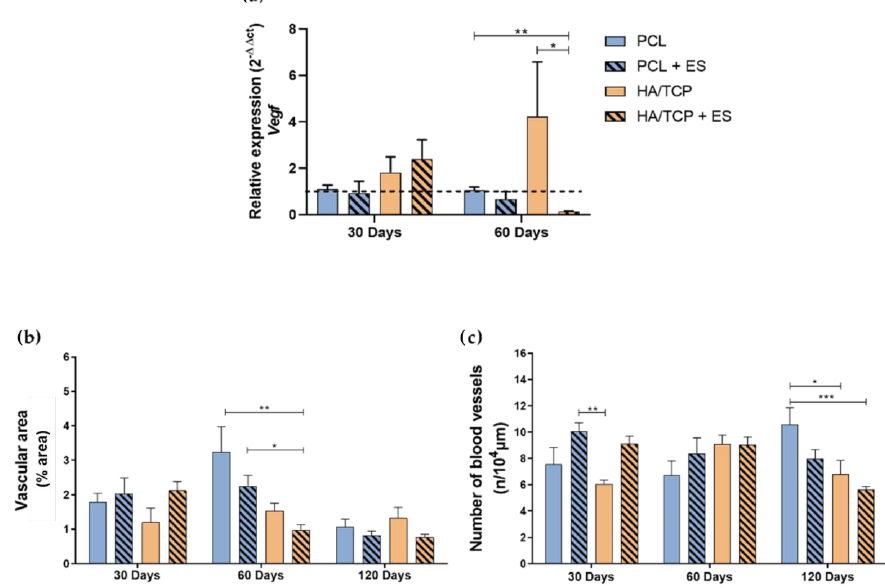
Figure 6. Evaluation of angiogenesis by ( a ) relative expression of Vegf (2 − ∆∆ ct ); ( b ) vascular area and ( c ) number of blood vessels formed by imaging. Results were expressed as mean ± standard error of the mean (significance levels were established in * p < 0.05, ** p < 0.01, *** p < 0.001). Figure 7 represents the histological images of the Masson’s trichrome stained bone defect area treated with different scaffolds as well as the semi-quantification of the percentage of mineralized tissue at days 30, 60 and 120. As observed from Figure 7a, HA/TCP and HA/TCP + ES groups presented compact and dense bone at day 30 and this trend was strengthened along with the implantation time. The quantification of bone formation is shown in Figure 7b. As illustrated in Figure 7a, since day 30, HA/TCP and HA/TCP + ES groups showed greater mineralization than PCL and PCL + ES groups. Similar trend was also observed at days 60 and 120 with a constant increase in mineralized tissue, particularly in the HA/TCP and HA/TCP + ES groups.